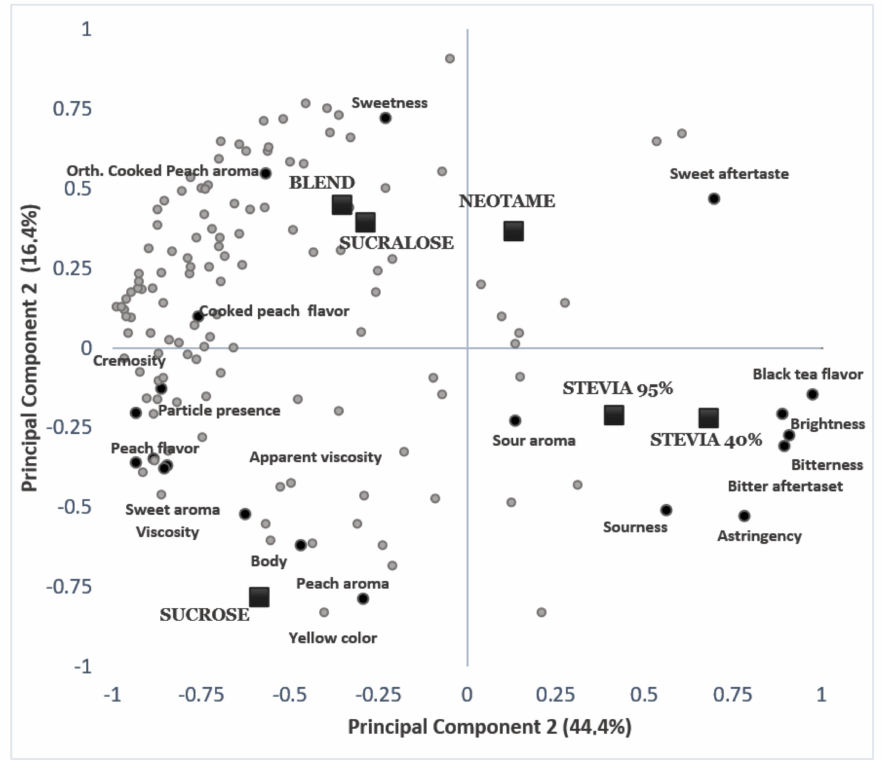
Figure 2. External preference mapping obtained by partial least squares regression of the descriptive sensory profile and consumers’ overall impressions of the functional peach juice. (Square = samples; grey points = consumers; black points = quantitative descriptive analysis